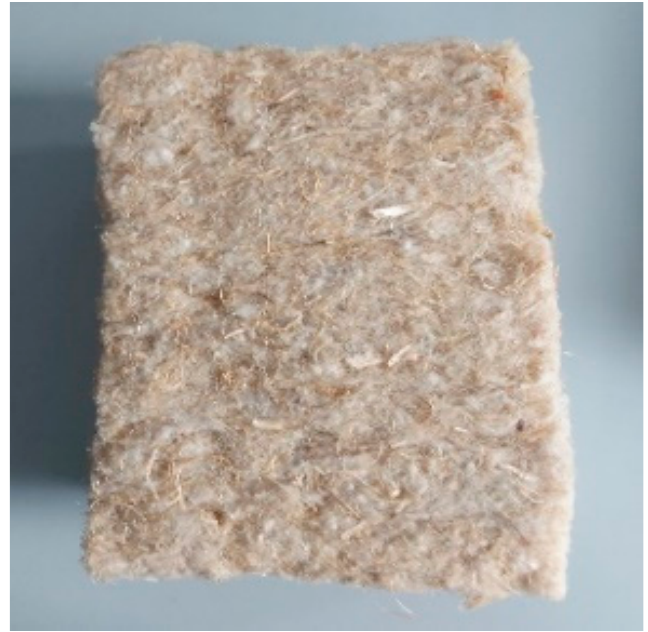
Figure 4. Hemp fiber.